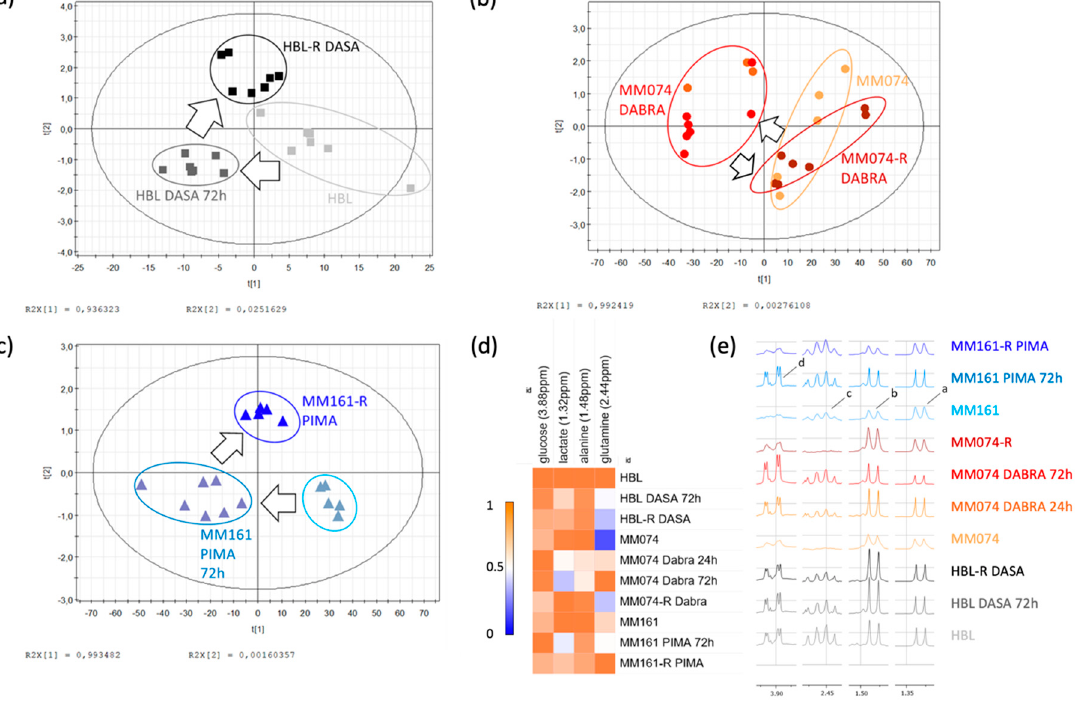
Figure 3. Scores plots showing the evolution of the culture media composition from an initial to a resistant status, in the case of cKIT ( a ), BRAF-V600E ( b ), and N-RAS ( c ) acquired resistance. Arrows were used to draw the metabolic path followed by sensitive cells during resistance acquisition. ( d ) Heatmap of the 4 EC discriminant metabolites identified between the 3 considered cell lines and experimental conditions. ( e ) NMR spectra of the EC compartments highlighting the discriminant identified metabolites, tagged as follows: a: lactate; b: alanine; c: glutamine; d: glucose.